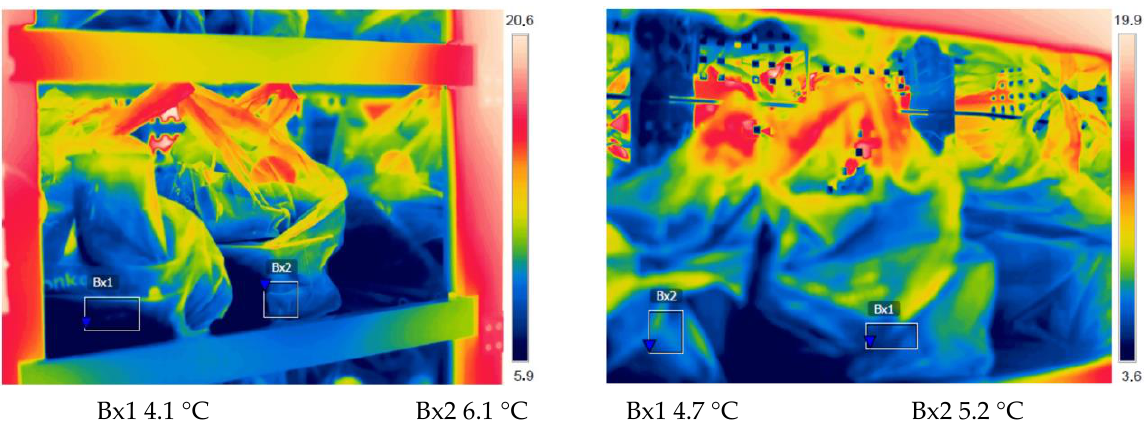
Figure 8. Thermograms for the filled chamber 2 of the cooling module immediately after storage.